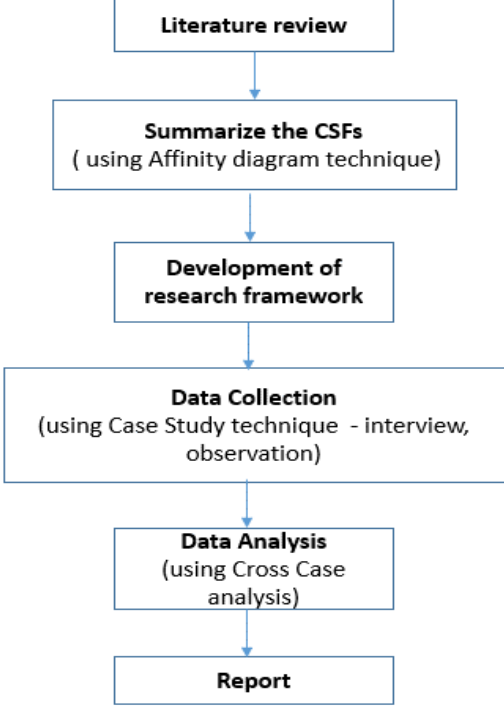
Figure 2. Flow for the activities in this